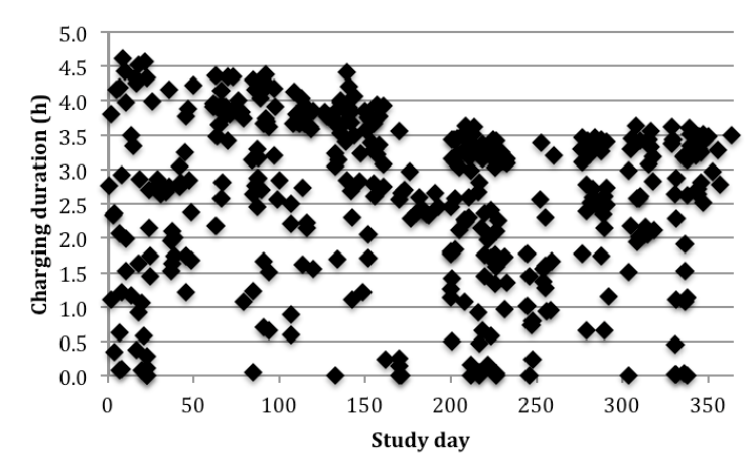
Figure A-2. Charging